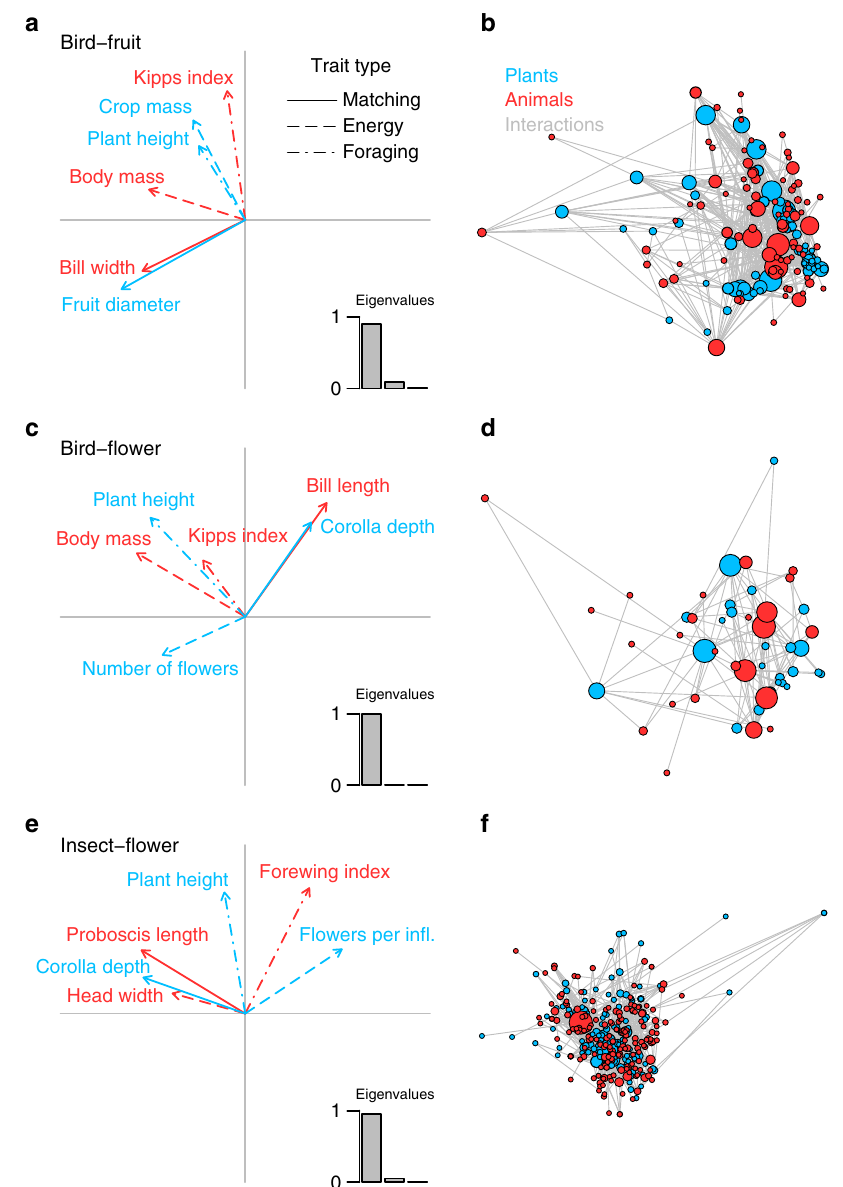
Fig. 2 Associations of plant and animal functional traits in different types of plant – animal mutualistic networks. Results of a combination of RLQ and fourth- corner analyses for a , b bird – fruit, c , d bird – fl ower, and e , f insect – fl ower mutualisms. We use RLQ analysis ( a , c , e ) to map the multivariate trait space of animals on the multivariate trait space of plants based on plant – animal interaction networks. The eigenvalues of the RLQ analysis in a , c , e indicate the proportion of the cross-covariance between plant and animal trait spaces explained by each RLQ axis 25 . Vectors in a , c , e depict the coef fi cients of plant (blue) and animal (red) traits on the fi rst two axes of the plant and animal trait spaces from RLQ analysis. If two vectors are long and point into the same or opposite directions the absolute correlation coef fi cient between the corresponding traits is large. Different line types in a , c , e indicate different types of functional traits, related to size matching (continuous line), energy provisioning of plants and energy requirements of animals (long-dashed line), as well as foraging stratum and mobility (dash-dotted line). b , d , f Representation of the mutualistic networks in the multivariate trait spaces of plants and animals. Dots in b , d , f represent species scores of plants (blue) and animals (red) in their multivariate trait spaces and grey lines depict interactions between plants and animals. The size of the dots is proportional to the number of links that a species has (i.e., species